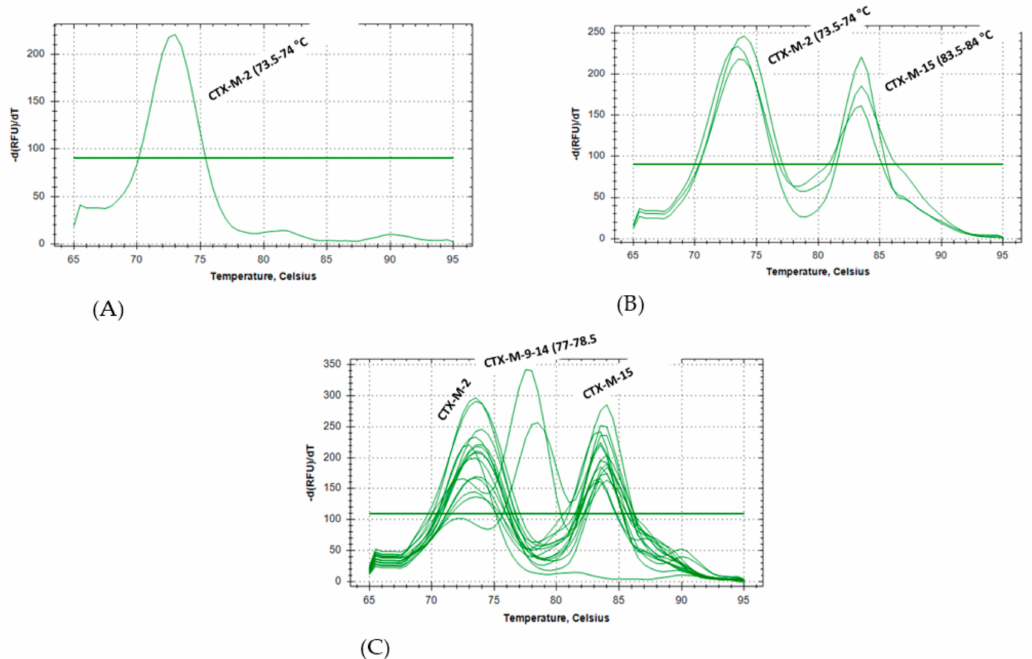
Figure 2. Illustrative plot showing detection of CTX-M through HRM analysis of E. coli isolates ( A ) an isolate with CTX-M-2, ( B ) three isolates with both CTX-M-2 and CTX-M-15, ( C ) 14 isolates with both CTX-M-2 + CTX-M-15, and two isolates with CTX-M-9. Melting temperatures (Tm) are shown for each HRM